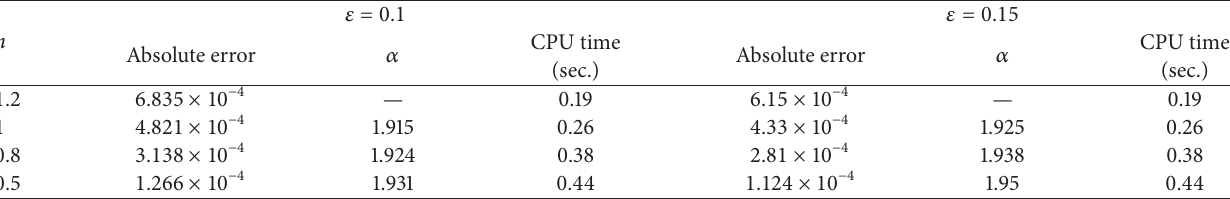
Table 1: Errors and convergence rates due to the change of ℎ for VG.